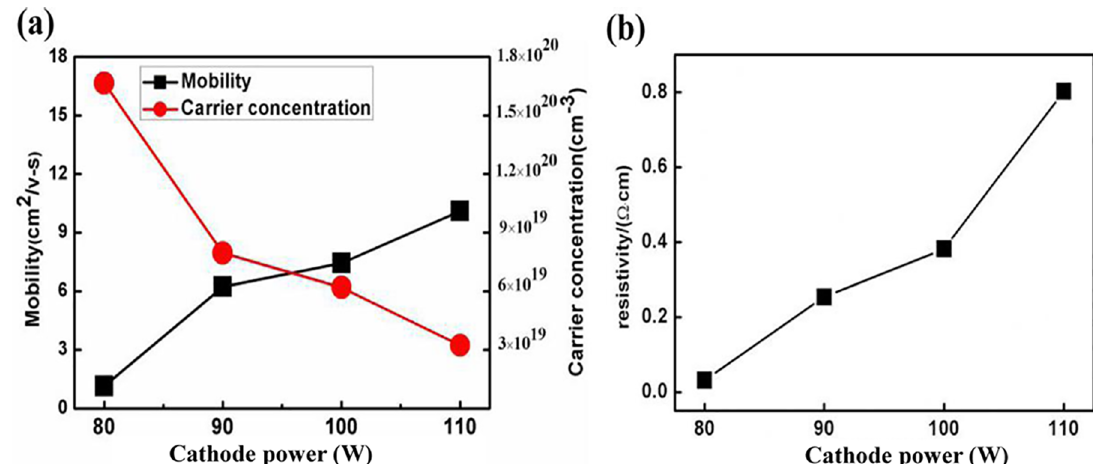
Figure 5. (a) Hall mobilities and carrier concentrations of InN samples deposited on sapphire substrates at different sputtering powers, (b) Resistivities of InN samples at different sputtering